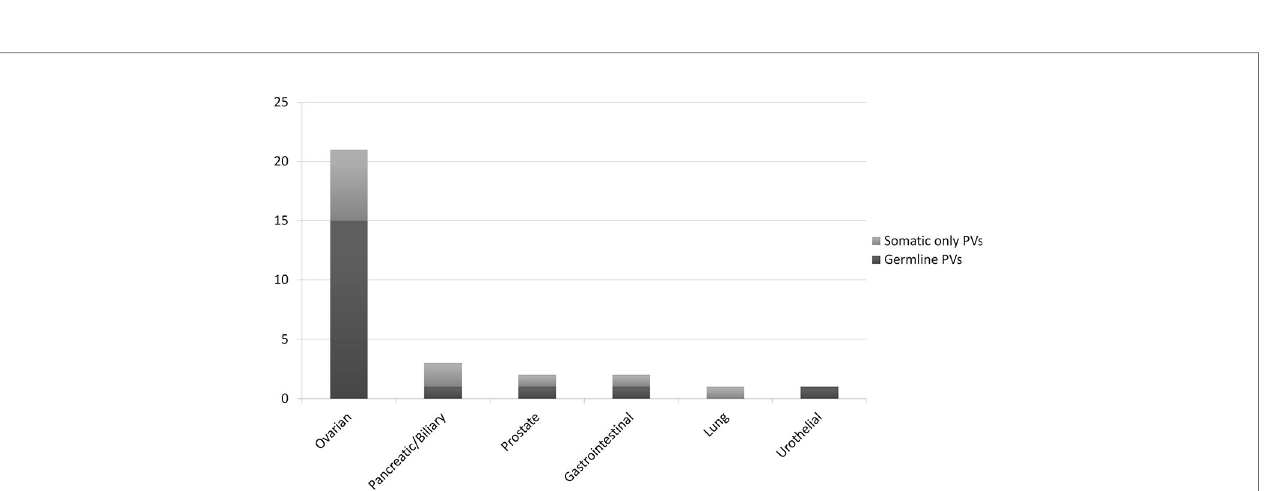
FIGURE 4 | Flowchart of tumour and germline BRCA testing results in the whole cohort. VUS, variants of uncertain signi fi cance; GC, genetic counselling; PVs, pathogenic/likely pathogenic